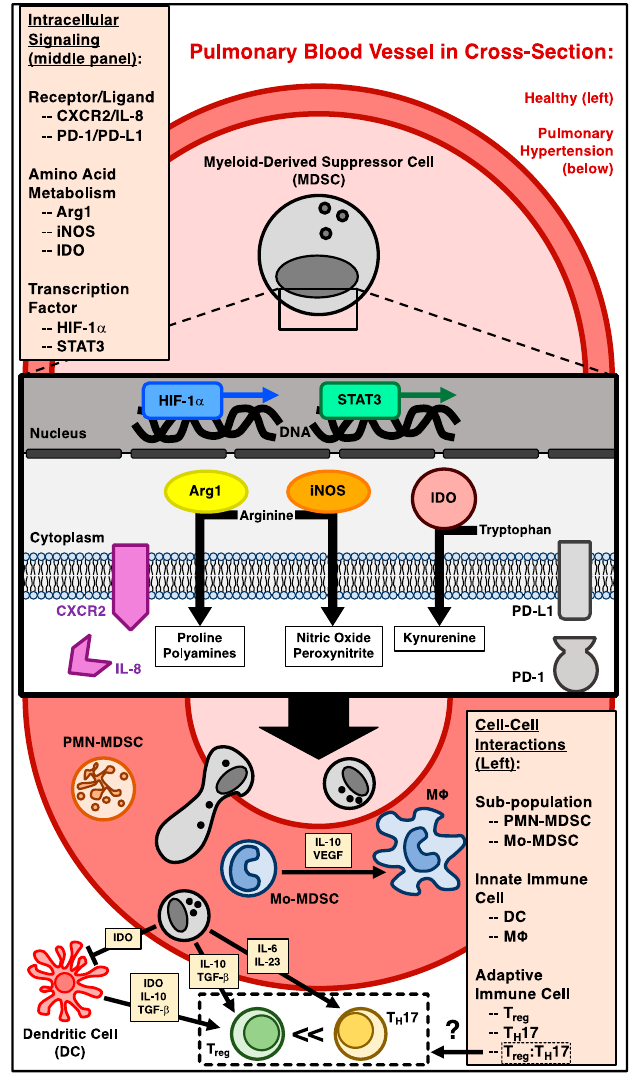
Figure 1. Illustration detailing potential myeloid-derived suppressor cell (MDSC) contributions to pulmonary vascular remodeling and development of pulmonary hypertension (PH). Displayed are proposed intracellular and intercellular MDSC-mediated mechanisms in the development of PH.